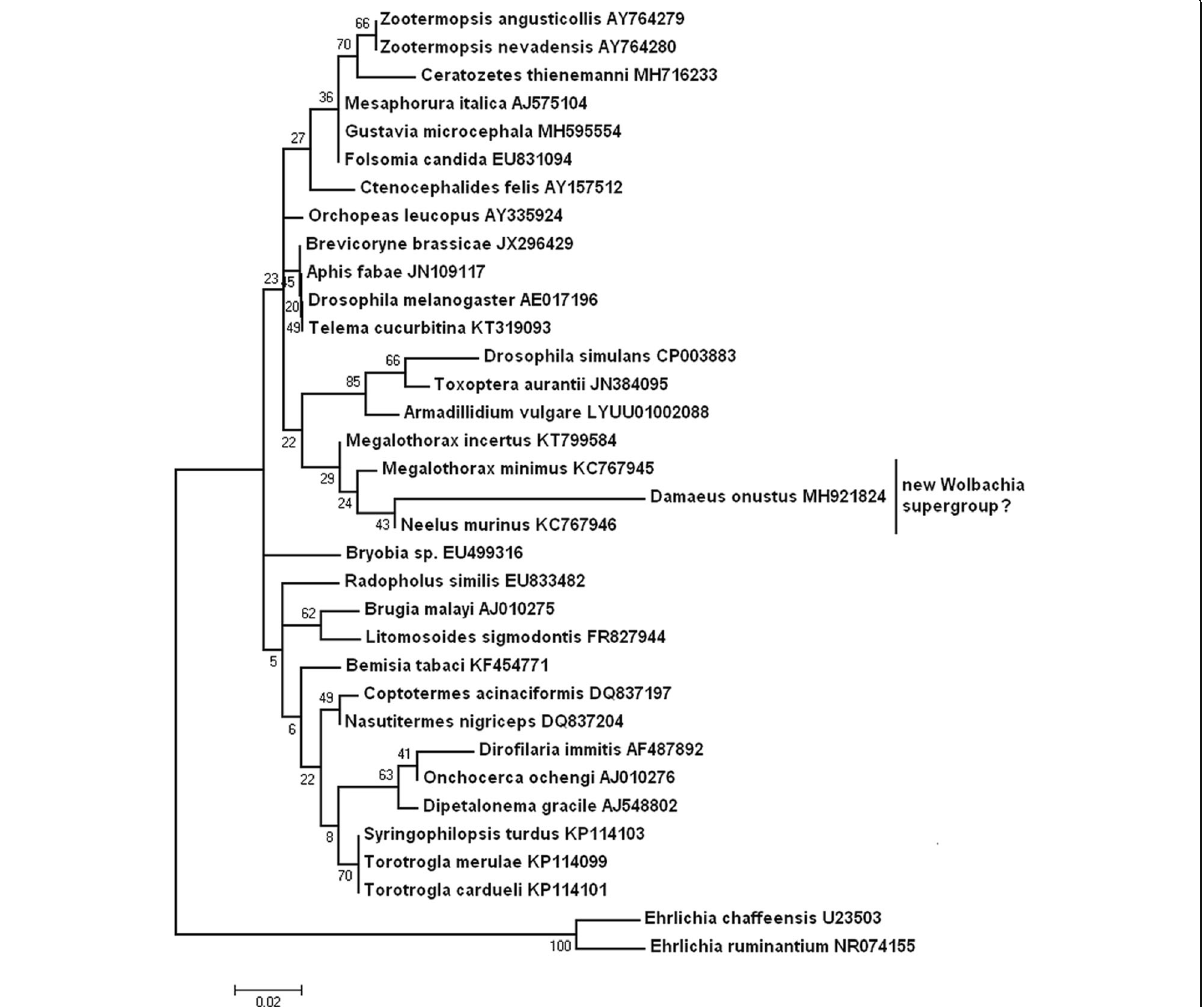
Fig. 1 Maximum likelihood reconstruction of Wolbachia phylogeny based on the sequences of 16S rDNA. Strains are designated by the names of their hosts, except for the outgroup. NCBI accession numbers for sequences are presented after the names of hosts. Bar, substitutions per nucleotide. Bootstrap values based on 1000 replicates are shown on the